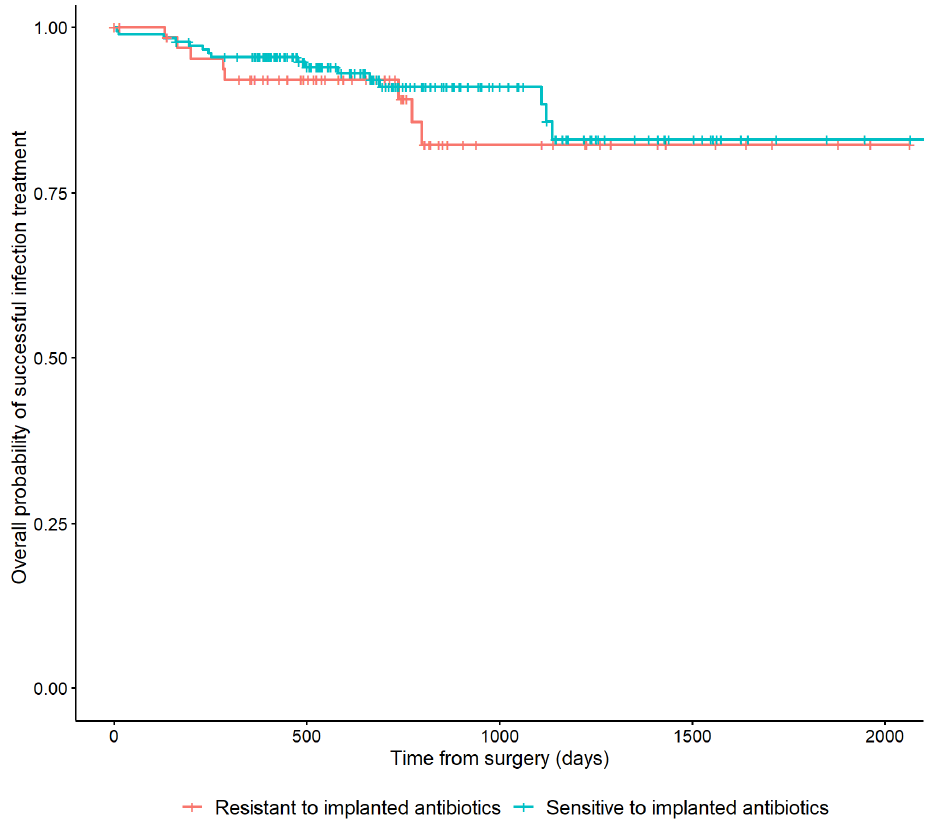
Figure 4. Kaplan–Meier Survivorship curve demonstrating the relationship between the microbiological sensitivity to the local antibiotics that have been applied and recurrence of FRI.